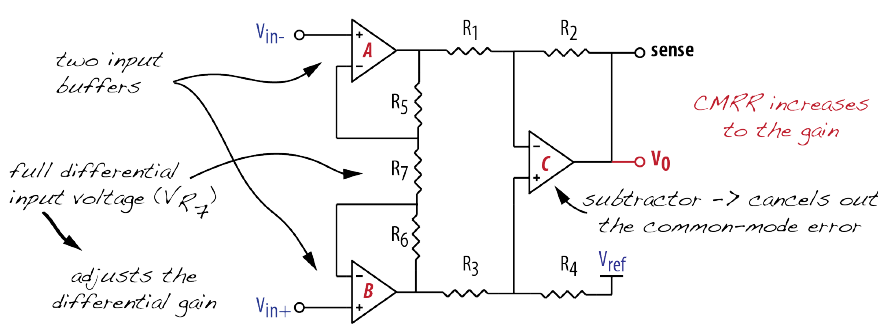
Figure 9. Instrumentation